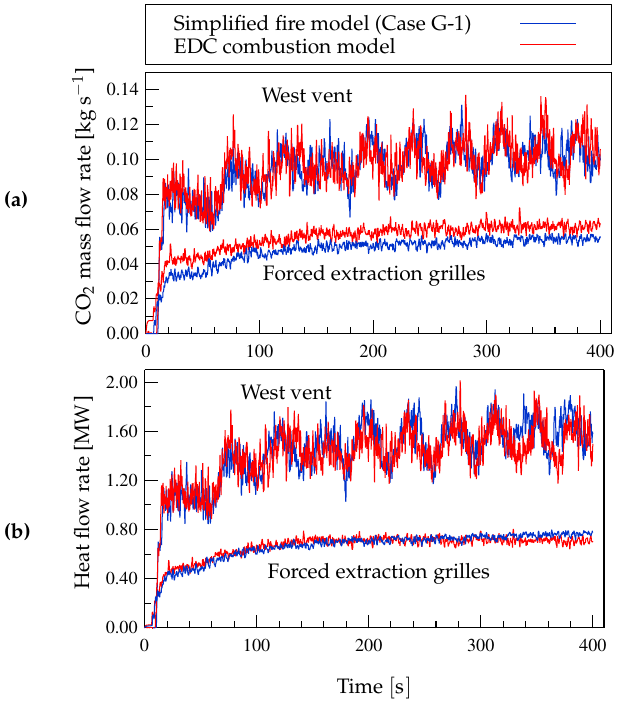
Figure 11. (a) Mass flow rates of CO 2 , and (b) heat flow rates through the ventilation systems, obtained with FDS as in Figure 8.